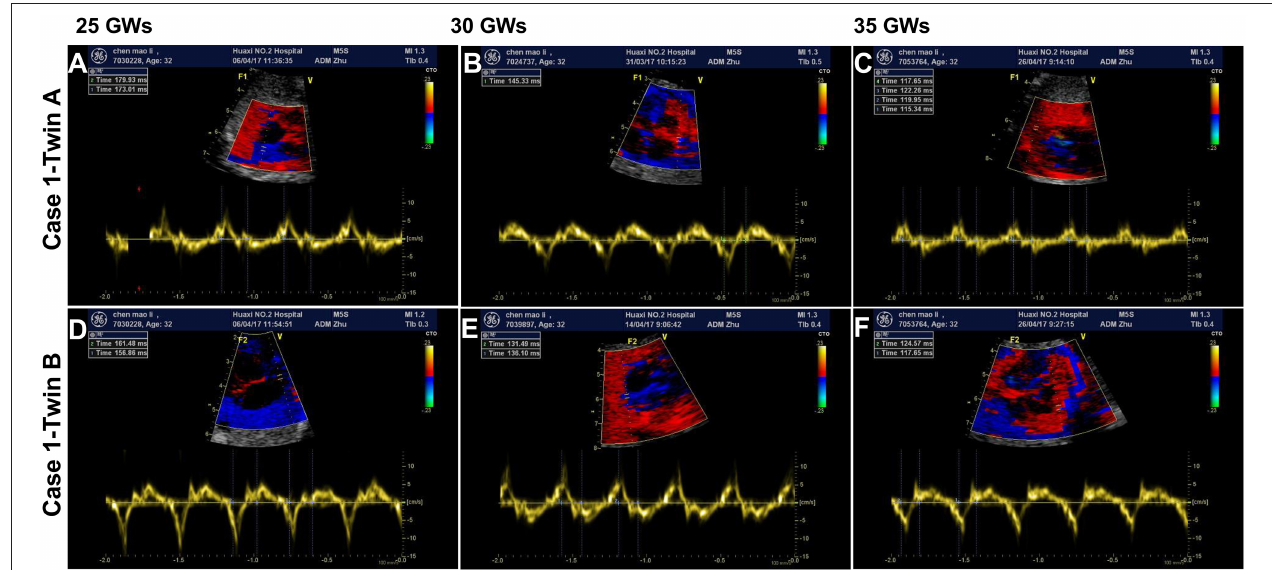
FIGURE 1 | The findings of fetal atrioventricular interval monitored by fetal echocardiography. (A,D) Show the fetal atrioventricular (AV) intervals upon diagnosis (170/160ms) at 25 gestational weeks (GWs). Panels B/E show the findings (145/136ms) of medium term after treatment with oral dexamethasone at 30 GWs. (C,F) Show the final echocardiography prior to delivery (130/127ms) at 35 GWs. (A–C) Belong to the fetus of case 1-twin A, and (D–F) belong to the fetus of case 1-twin B. ms, millisecond.